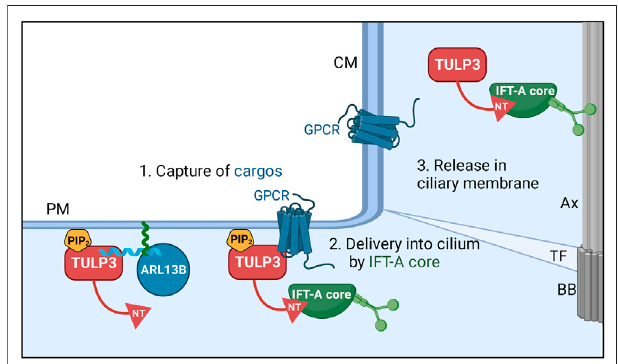
FIGURE 3 | Model for TULP3 and IFT-A — mediated traf fi cking of cargoes into cilia. TULP3 tubby domain is anchored to the plasma membrane by PI(4,5)P 2. The tubby domain captures short CLS (cilia localization signal) peptide regions in diverse cargoes. The N-terminus (NT) of TULP3 binds to the IFT-A core subunits (IFT140, IFT122, IFT144) and recruits the tubby domain-bound cargoes to cilia. After reaching cilia, the lack of PI(4,5)P 2 in the ciliary membrane could dislodge the cargoes from the tubby domain. The cargoes are very diverse and include transmembrane proteins and membrane-associated proteins such as ARL13B. The N-terminus amphipathic helix in ARL13B that binds the tubby domain in TULP3 is shown in blue. ARL13B isanchored tothemembraneby palmitoylation (green) inside the helix. Abbreviations: Ax, Axoneme; TF, transition fi ber; BB, Basal body; CM, ciliary membrane; PM, plasma membrane. Created in